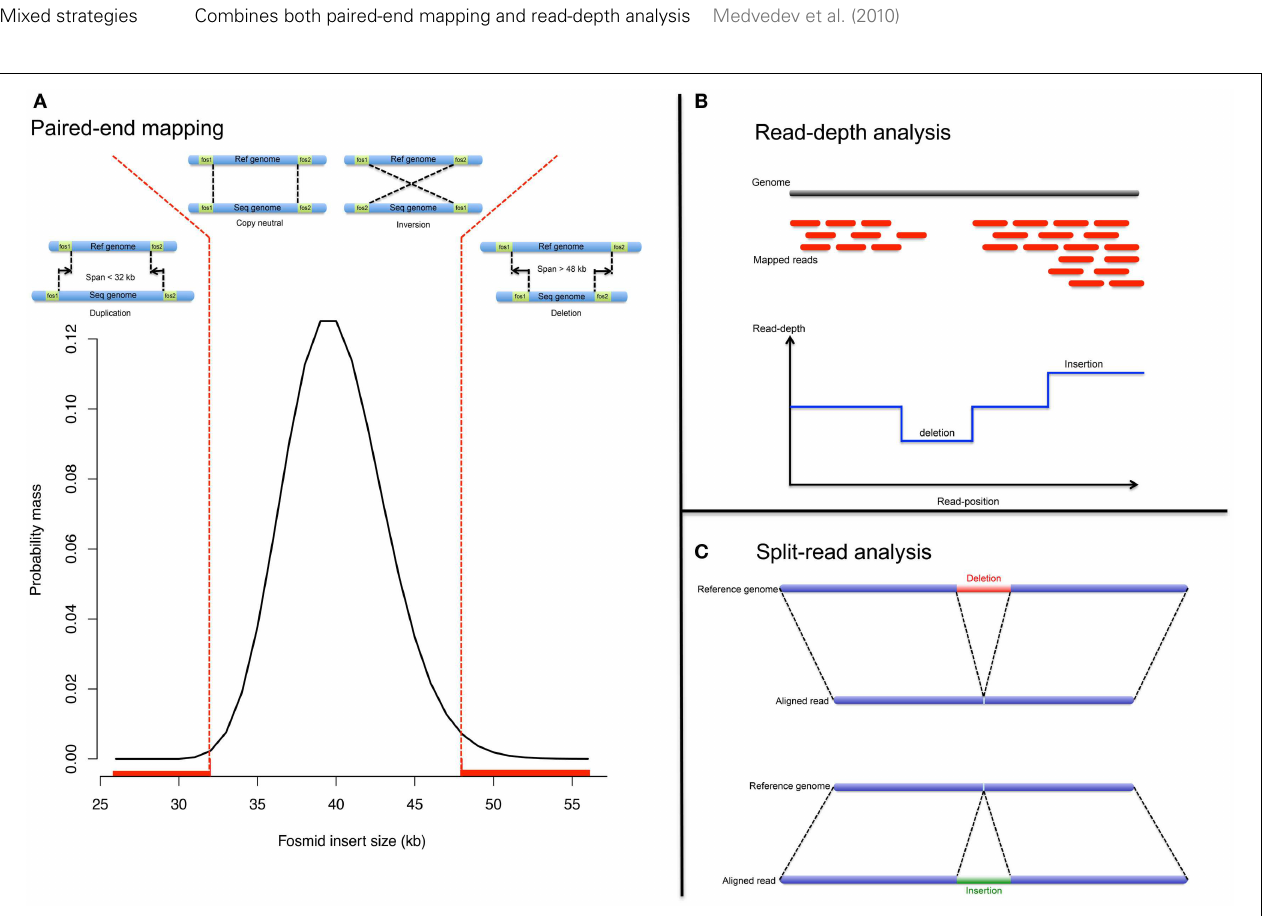
FIGURE 2 | NGS approaches . Analytical strategy to detect CNV from NGS data: (A) pair-end mapping approached, (B) read-depth approach, and (C) split-read approach.